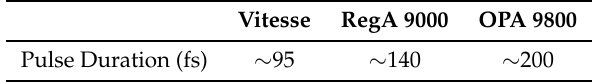
Table 1. Measured value of pulse duration for each laser